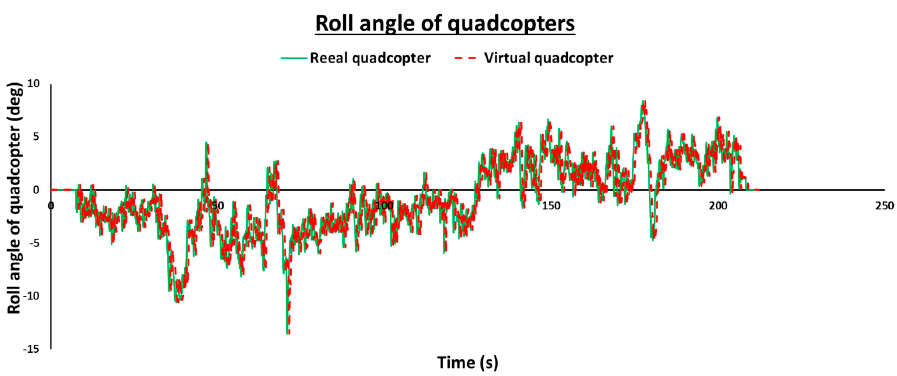
Figure 24. Pitch angle comparison of the real and the virtual quadcopters.